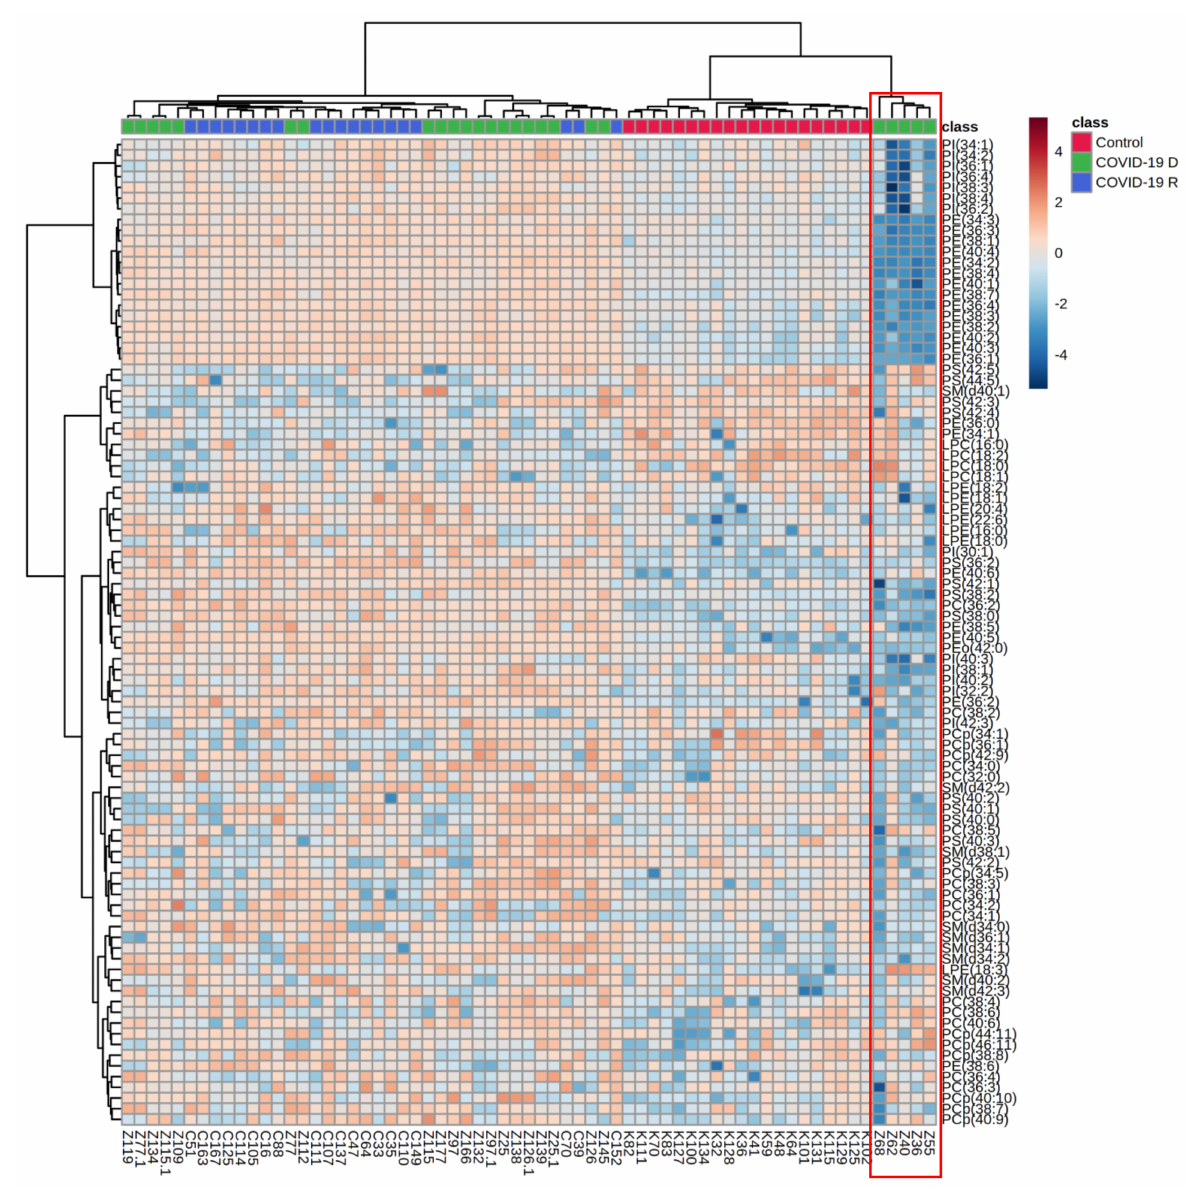
Figure 1. Two-dimensional hierarchical clustering heat map of the 50 most discriminating phospho- lipid species (according to One-way ANOVA) identified in the plasma of healthy subjects ( n = 20) [Control], deceased COVID-19 patients ( n = 20) [COVID-19 D] and COVID-19 recovered patients ( n = 20) [COVID-19 R]